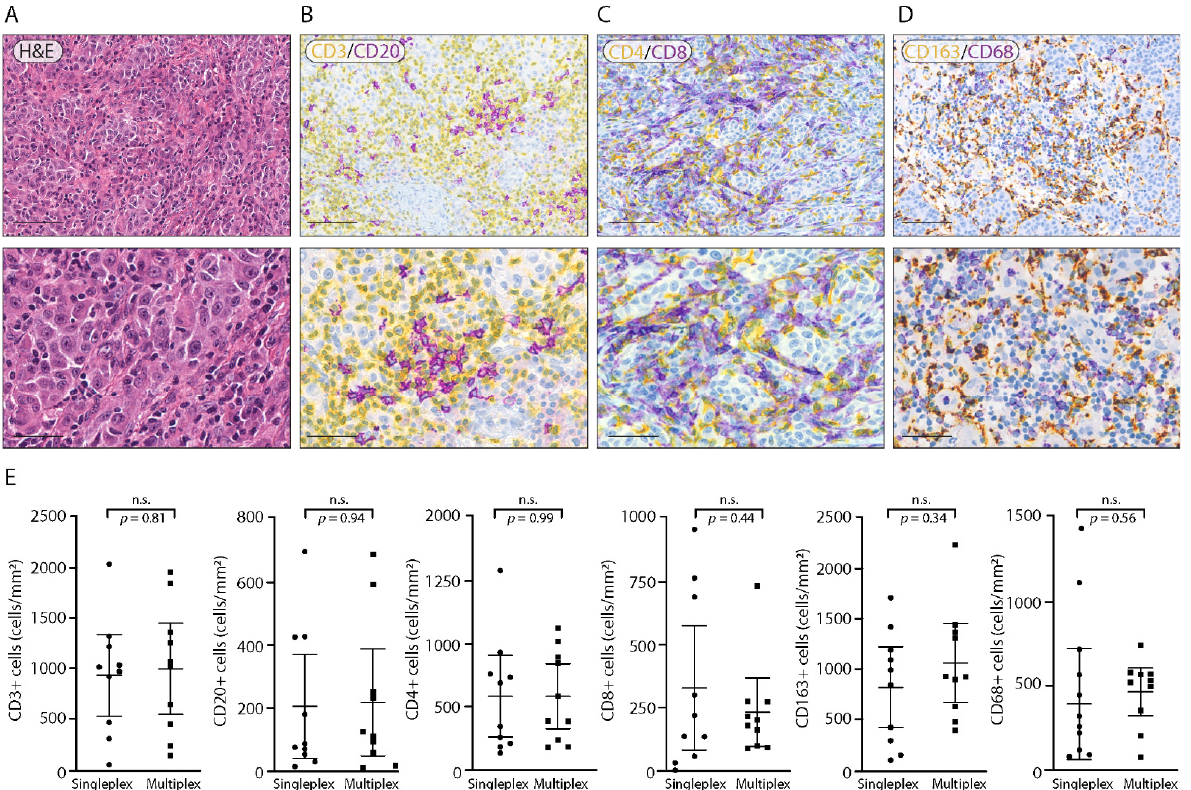
Figure 2. Representative double-labeling BF multiplex IHC of melanoma tissue and pooled data of CD3-, CD20-, CD4-, CD8-, CD163- and CD68-positive cell density comparisons between single and multiplex IHC. ( A ) Representative images of hematoxylin and eosin staining. ( B ) Representative image of double CD3/CD20 staining with Yellow (CD3) and Purple (CD20) chromogens. ( C ) Representative image of double CD4/CD8 staining with Yellow (CD4) and Purple (CD8) chromogens. ( D ) Representative image of double CD163/CD68 staining with Yellow (CD163) and Purple (CD68) chromogens. Magnification: 200× and 400× (scale bar: 100 µm and 50 µm). ( E ) Quantitative analysis of CD3-, CD20-, CD4-, CD8-, CD163- and CD68-positive cells in singleplex stained samples ( n = 10) and multiplex stained samples ( n = 10). Error bars represent 95% confidence intervals. All the statistical analyses were performed using unpaired two-tailed Student’s t tests. n.s.–not significant. Unpaired-sample t -tests were run to determine if there were differences between CD3 singleplex/CD3 multiplex, CD20 singleplex/CD20 multiplex, CD4 singleplex/CD4 multi- plex, CD8 singleplex/CD8 multiplex, CD163 singleplex/CD163 multiplex and CD68 single- plex/CD68 multiplex staining (Figure 2E). No differences were observed for CD3 singleplex (mean: 919.1 ± 565.9) and CD3 multiplex (mean: 983.0 ± 634.2), p = 0.081; for CD20 single- plex (mean: 206.5 ± 231.5) and CD20 multiplex (mean: 213.2 ± 237.8), p = 0.094; for CD4 singleplex (mean: 503.8 ± 484.5) and CD4 multiplex (mean: 577.4 ± 361.7), p = 0.070; for CD8 singleplex (mean: 333.1 ± 346.0) and CD8 multiplex (mean: 235.7 ± 189.7), p = 0.044; for CD163 singleplex (mean: 849.6 ± 560.1) and CD163 multiplex (mean: 1090.0 ± 550.4), p = 0.34; and for CD68 singleplex (mean: 391.8 ± 330.6) and CD68 multiplex (mean: 463.2 ± 198.4), p = 0.56. Quantitative evaluations confirm that there is no loss of anti- genicity due to the multiple cycles of